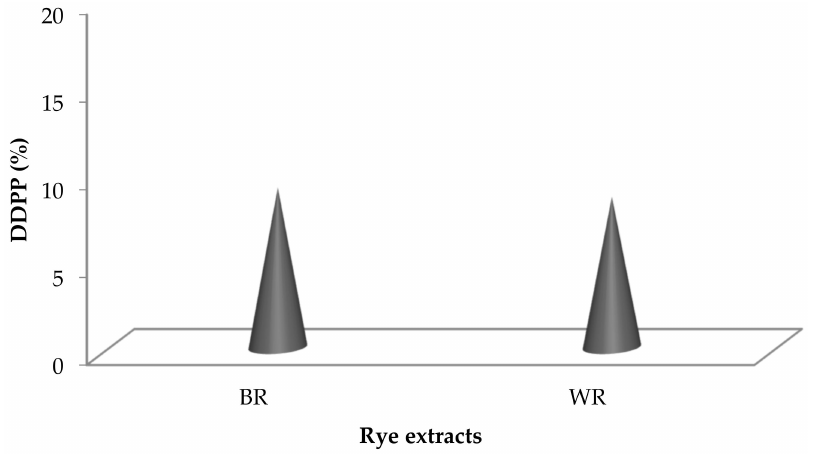
Figure 6. DDPP (%) in rye